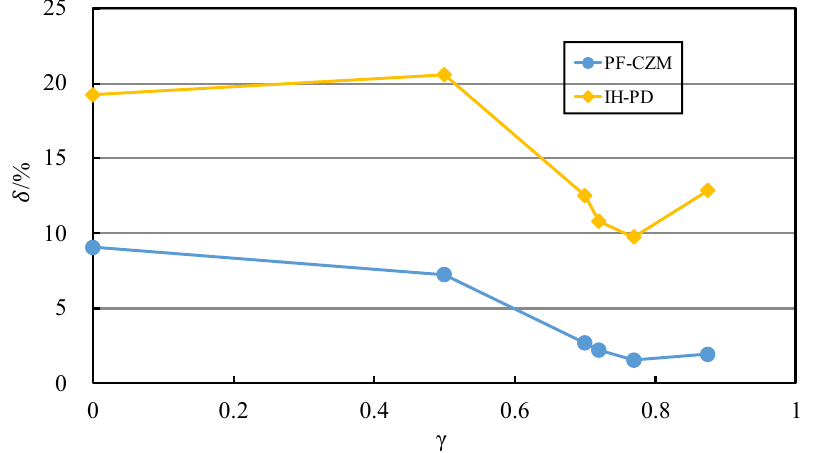
Figure 10. Relative error δ of predicted peak loads with different γ values from PF-CZM and IH- PD.